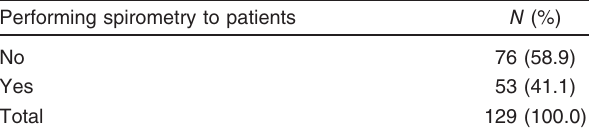
Table 10 Distribution of doctors according to performing spirometry to chronic obstructive pulmonary disease patients Performing spirometry to patients